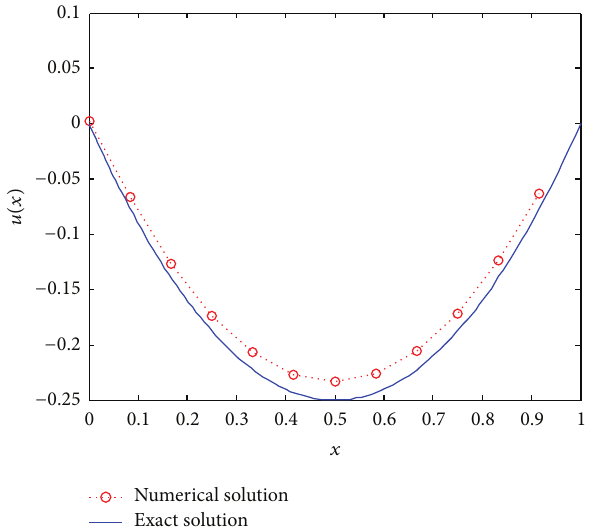
Figure2:Thecomparisonbetweennumericalandexactsolutionfor 𝑘 = 2 , 𝑀 = 1 .